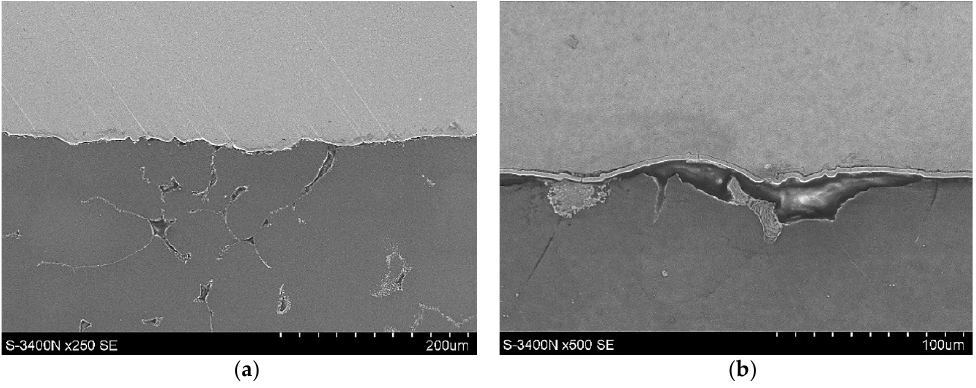
Figure 17. Stage 4 Casting-collector area: ( a ) porosity; ( b ) leakage (SEM).